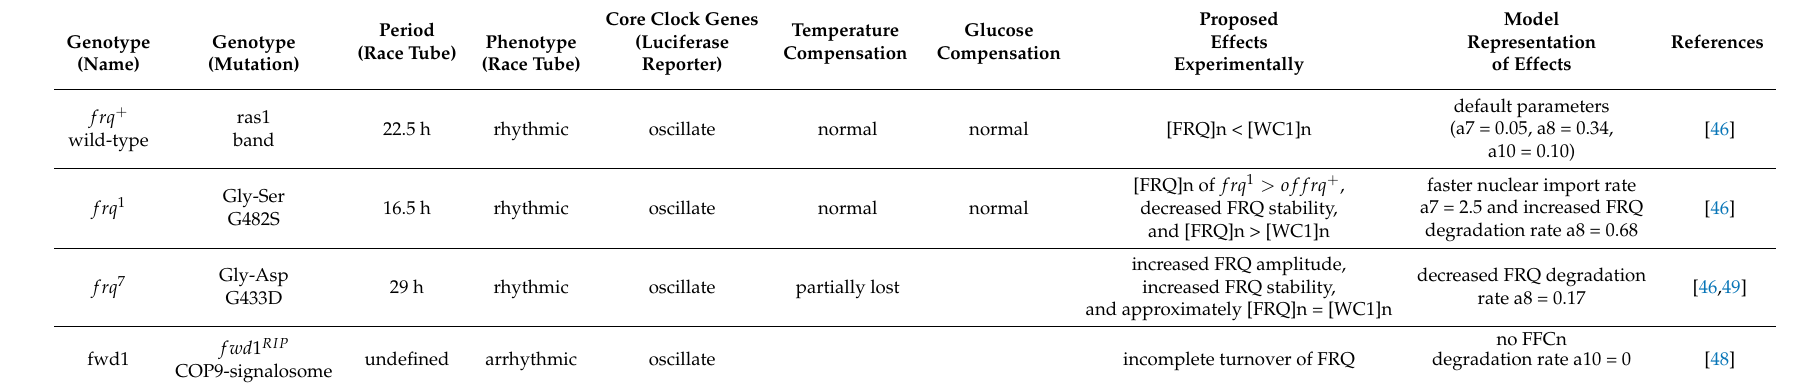
Table 1. Modeling Neurospora clock mutants: A list of selected mutants and their properties (simulations in Appendix Figure